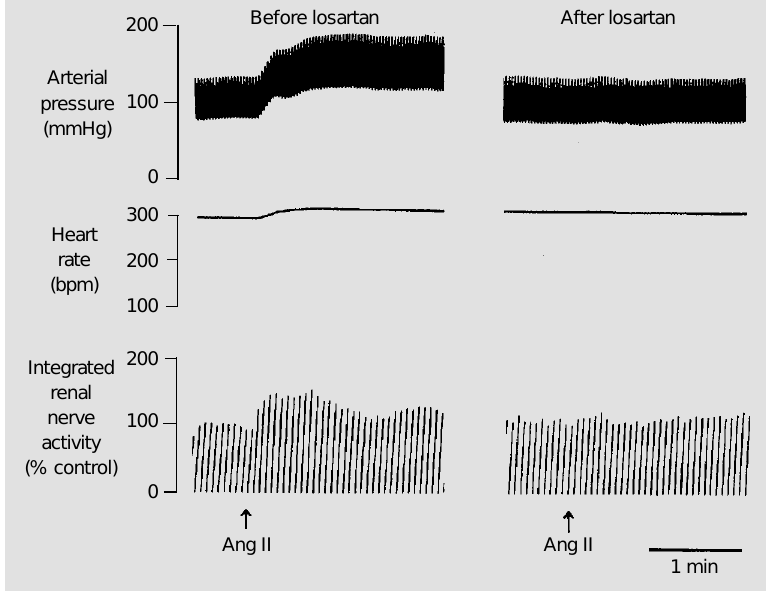
Figure 2 - Chart recording showing the effects on cardiovascular variables of microinjection of angiotensin II (Ang II, 40 pmol) into the pressor region in the rostral ventrolateral medulla before and after microinjection of losartan (1 nmol) into the same site (reprinted from Ref. 14, with the kind permission of the